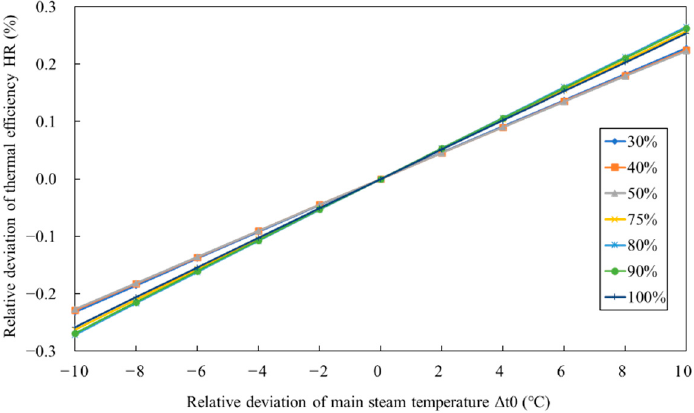
Figure 4. Variation in the relative deviation of thermal efficiency with main steam temperature disturbance under different output power loads.